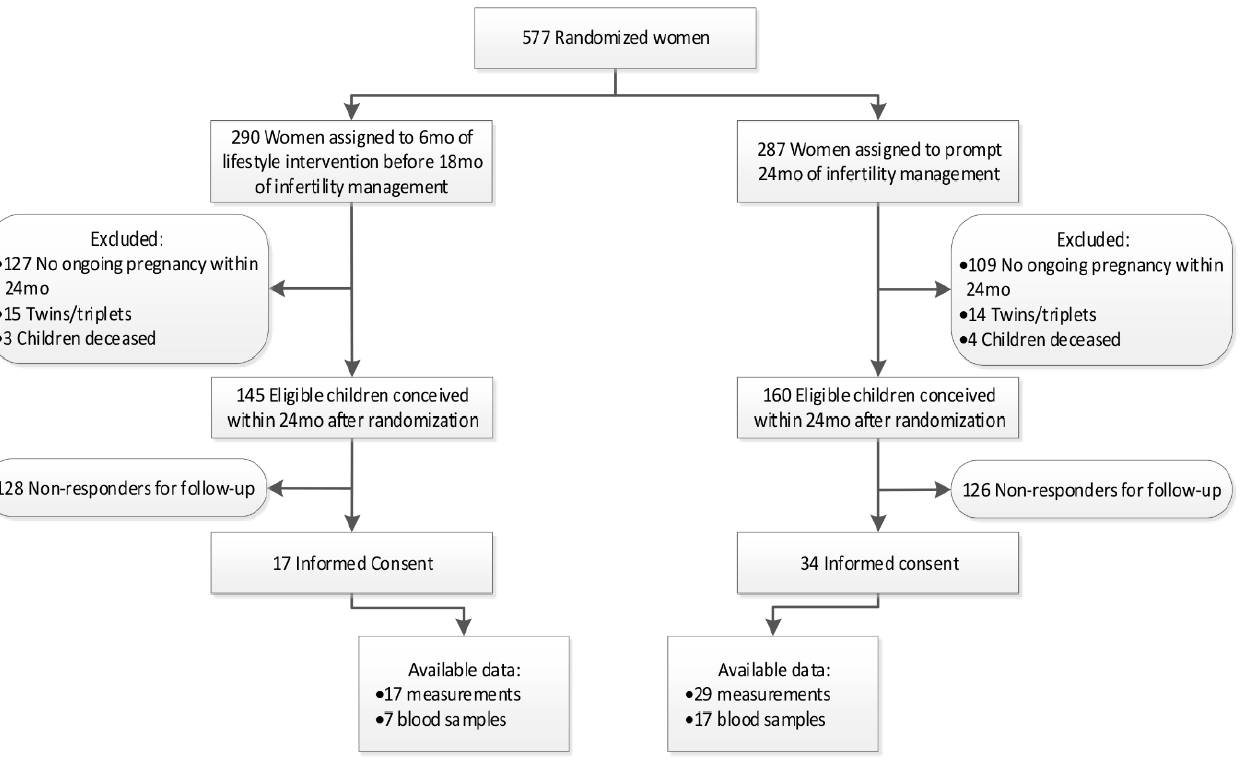
Figure 1. Flowchart of included participants. Mo = Months.